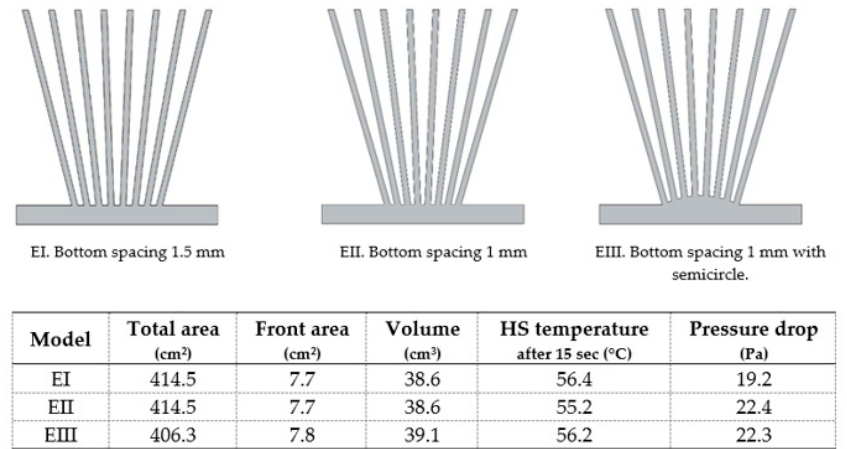
Figure 10. Model E variants.